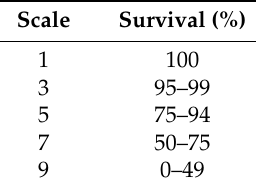
Table A1. Scale for scoring submergence tolerance of